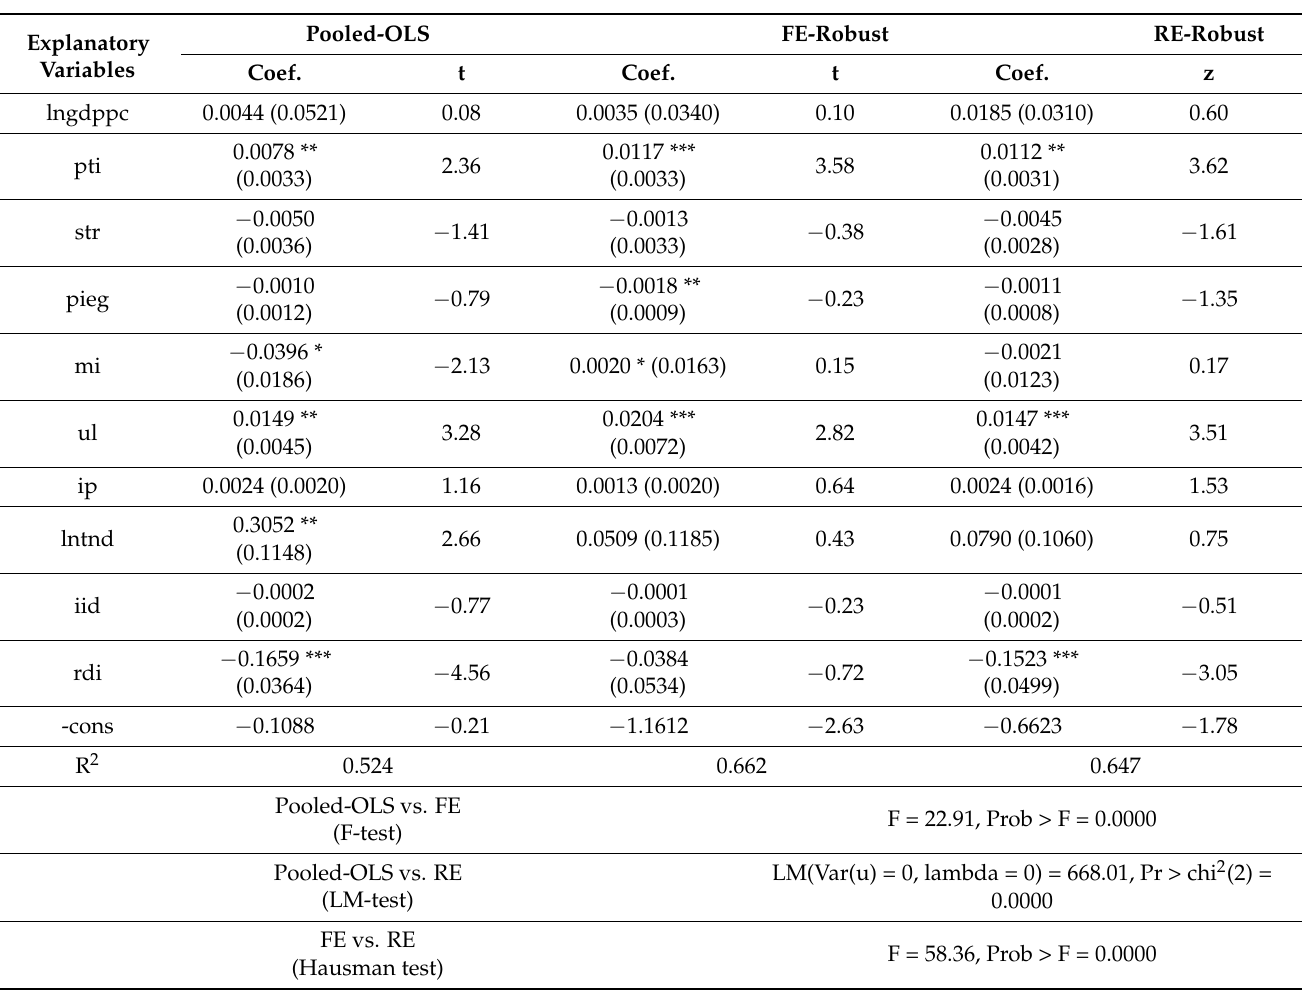
Table 4. Regression results of tourism-efficiency